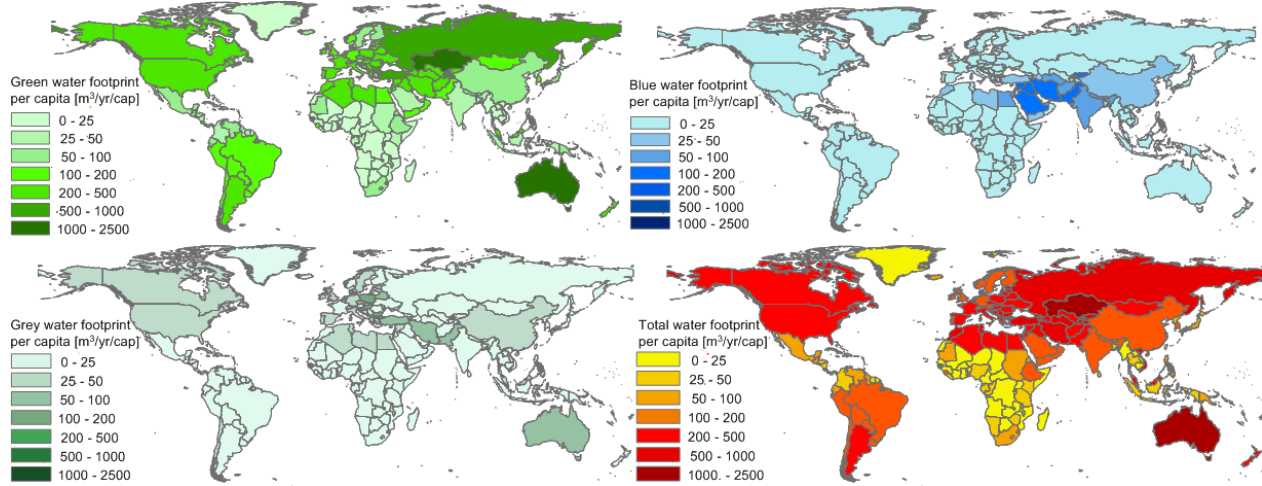
Fig. 5. Water footprint per capita related to consumption of wheat products in the period 1996–2005.